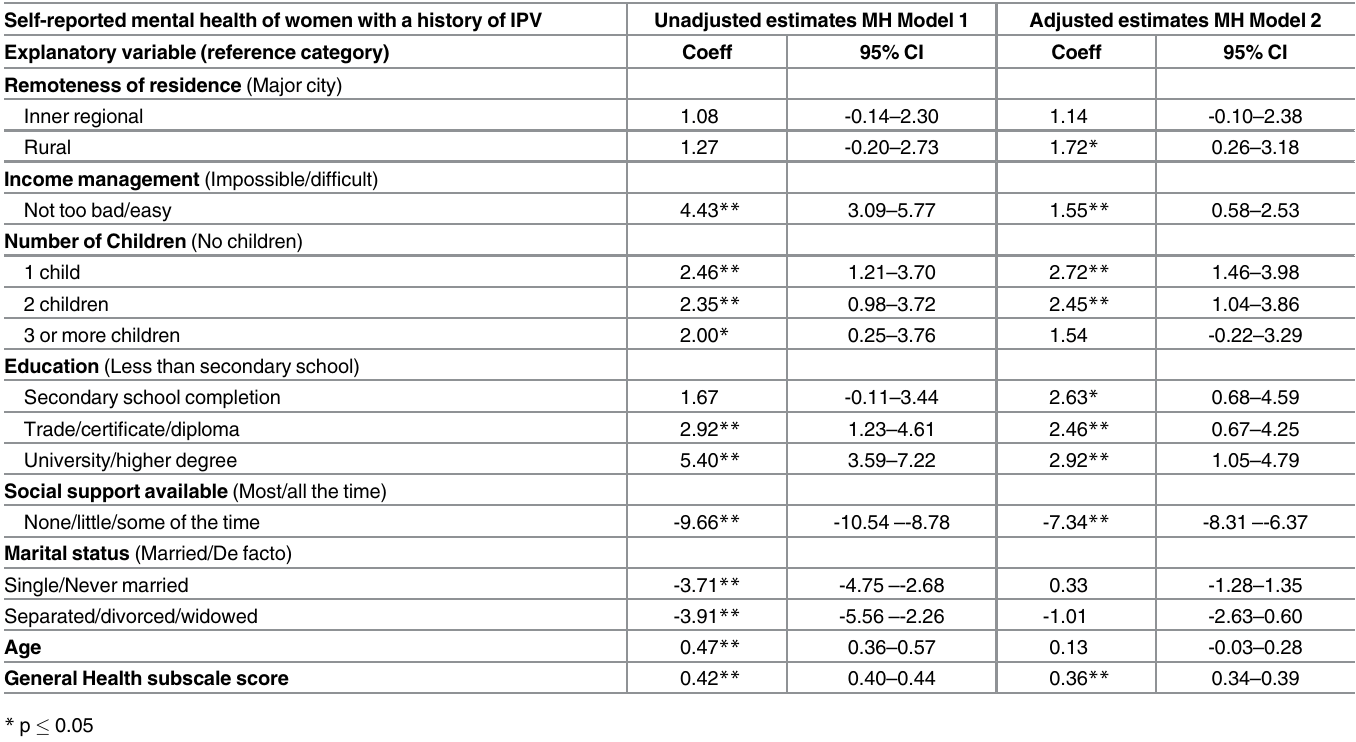
Table 3. Unadjusted and adjusted GEE models of factors associated with SF-36 Mental Health scores in women with a history of IPV. Self-reported mental health of women with a history of